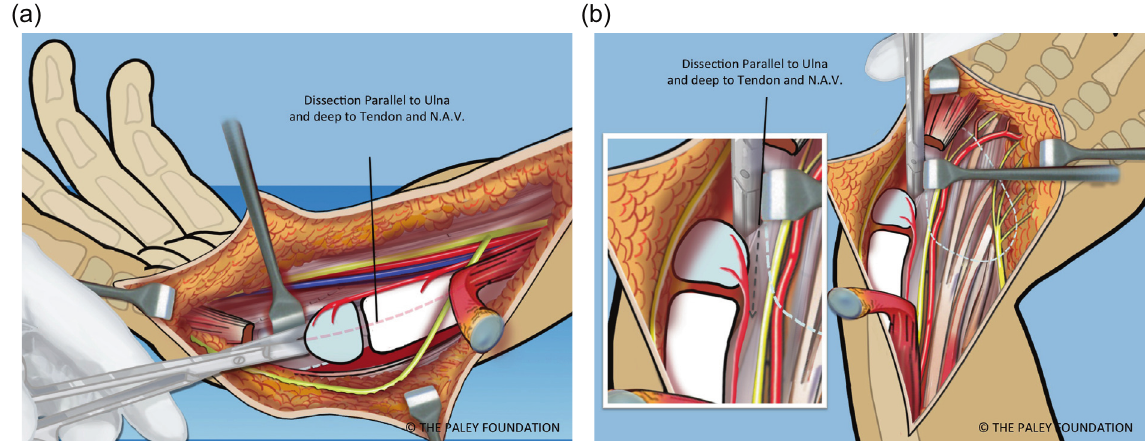
Figure 7. The capsule is released along the interval between the ulna and the carpus. The line of dissection is from distal to proximal, in line with the shaft of the ulna. Care must be taken to stay deep to the volar extra-articular soft tissues (a, b).